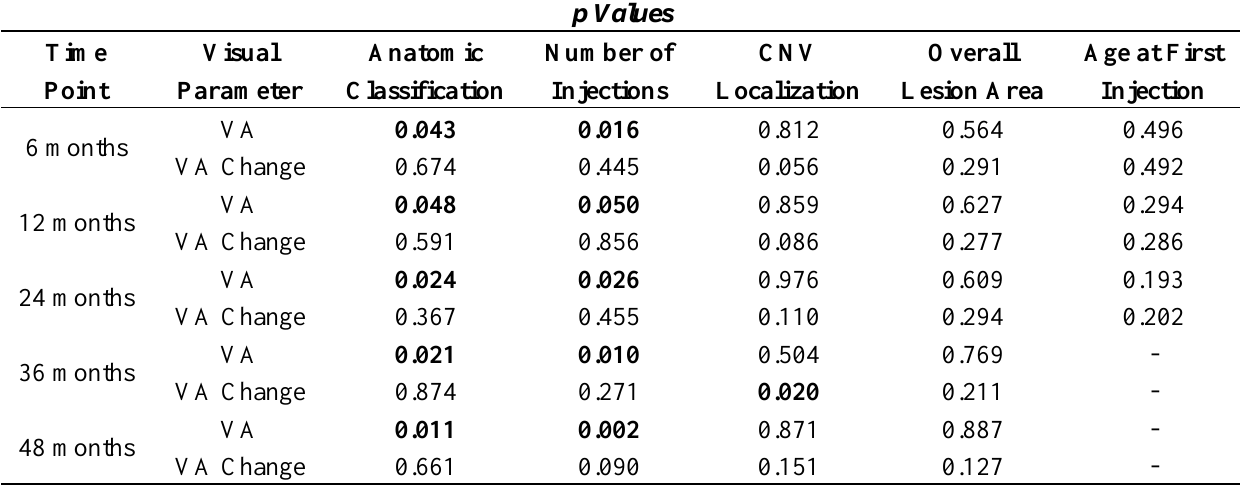
Table 5. Multivariate analysis of visual acuity and visual acuity change using baseline clinical parameters over time using patients with at least 4 years of follow up ( N =